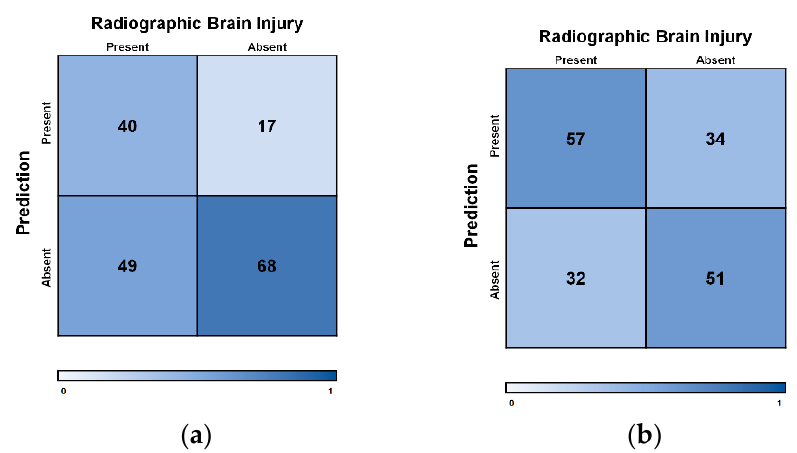
Figure A1. (a) Demonstrates model’s confusion matrix when limited to only initial 48 h of data. (b) Demonstrates model’s confusion matrix when limited to only initial 120 h of data.